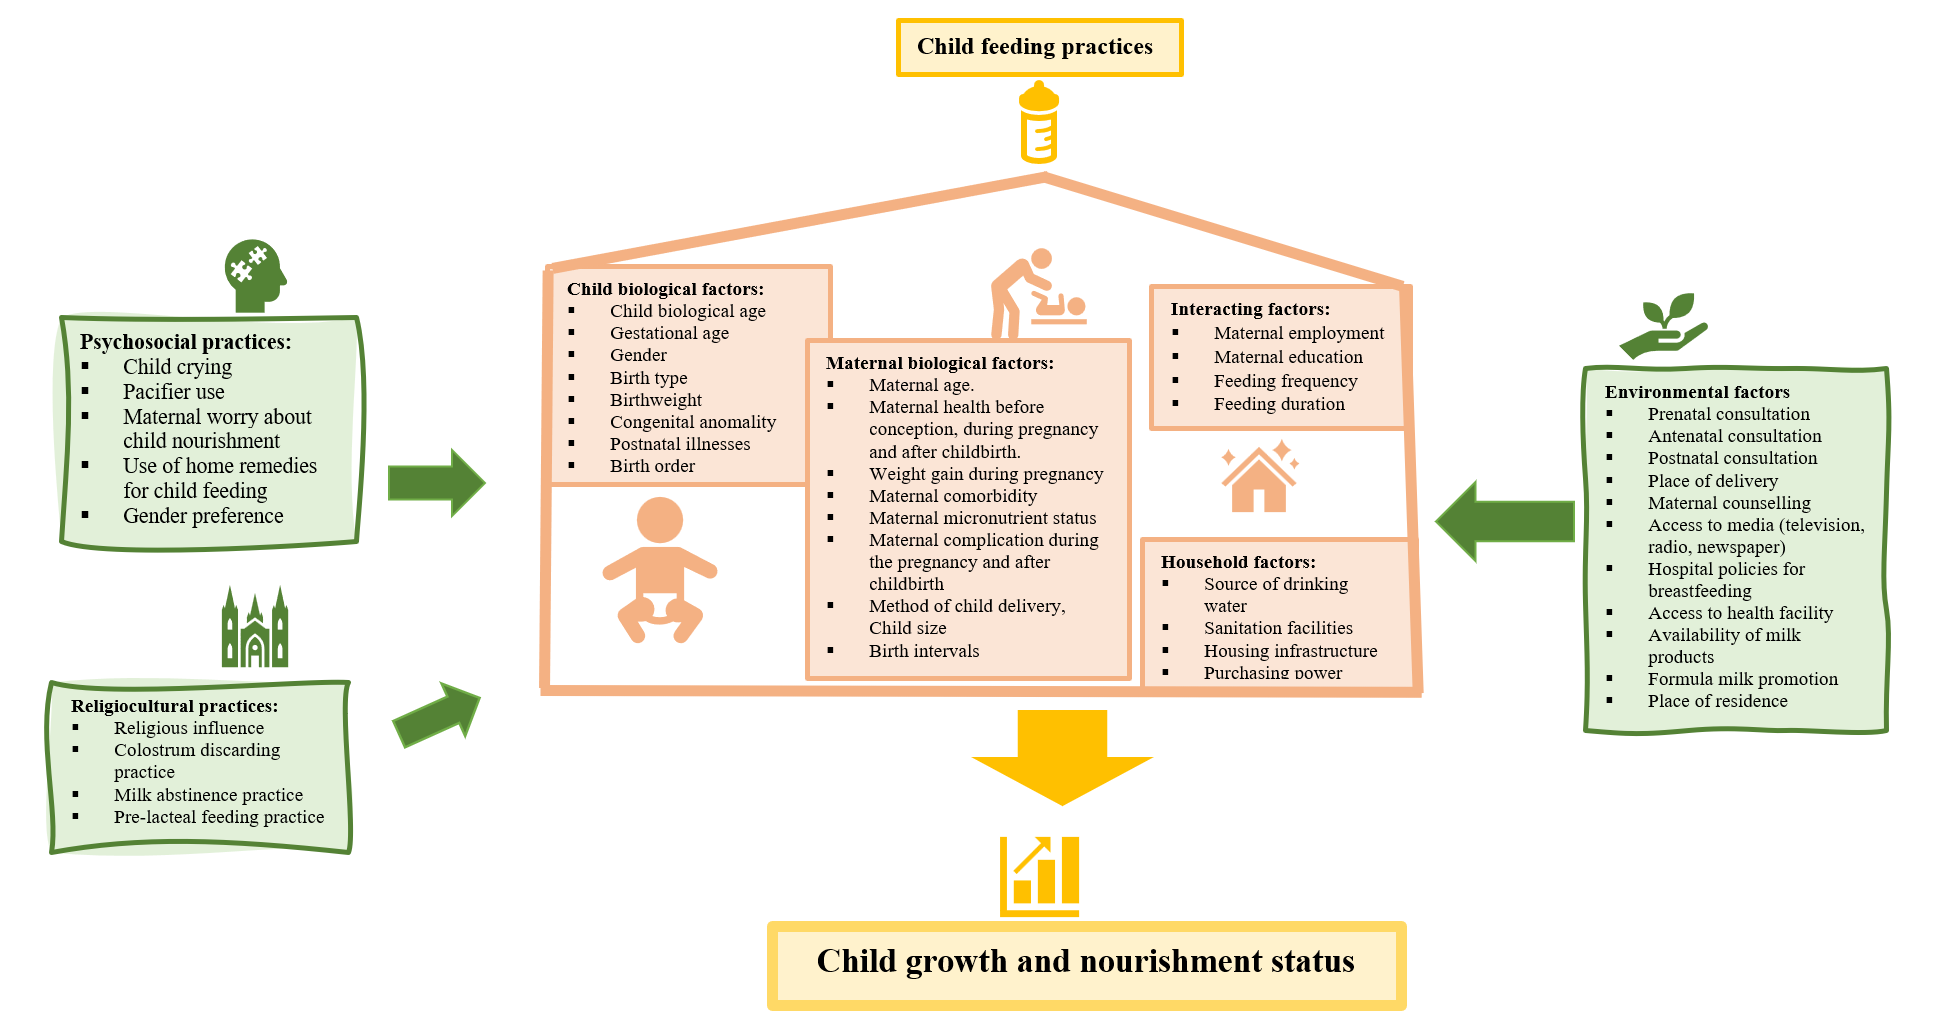
Figure 1. Conceptual framework indicating the relationship of an infant’s feeding practices with nutritional status.